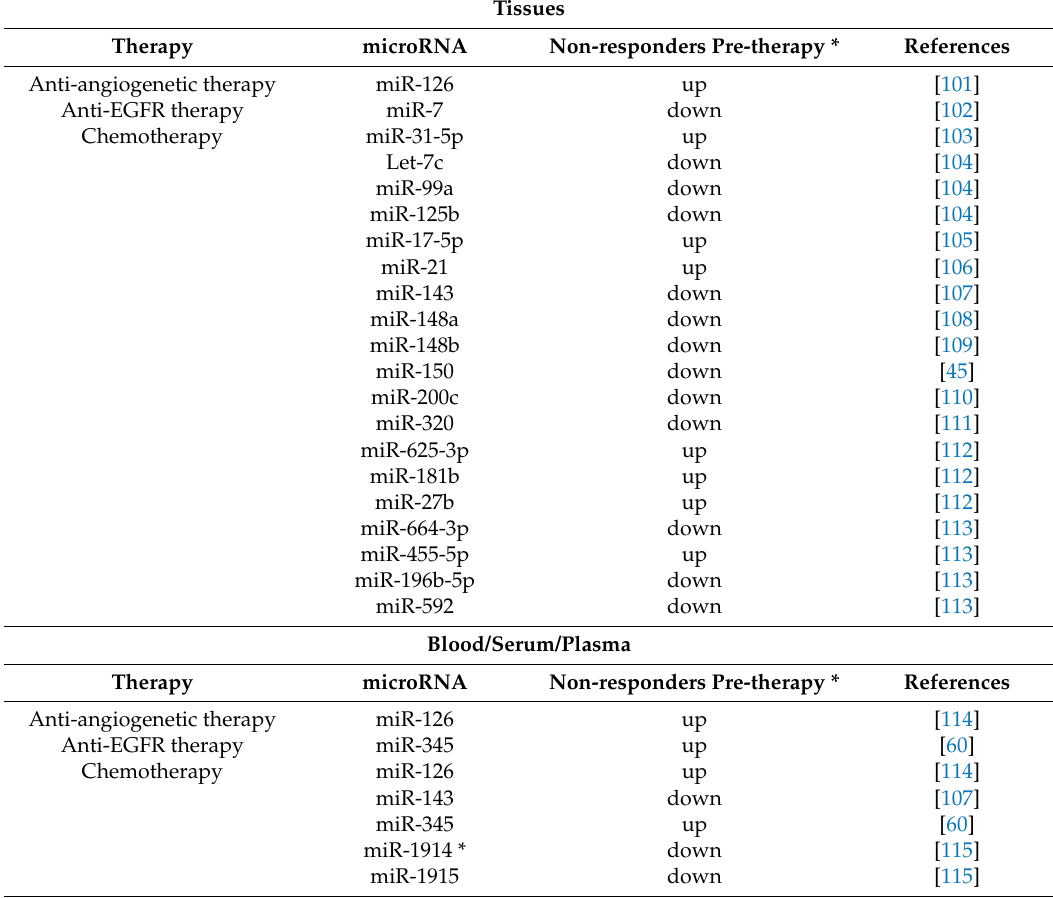
Table 3. Tissue and blood microRNA biomarkers for therapeutic response in